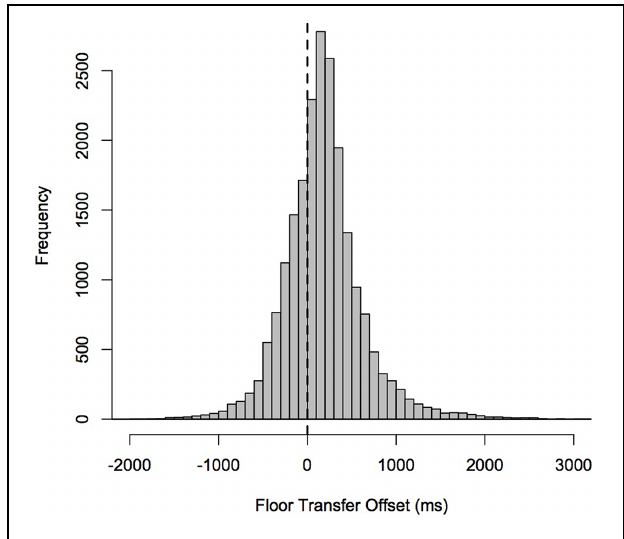
FIGURE 2 | Histogram of floor transfer offsets (FTOs) in the Switchboard Corpus (Godfrey et al., 1992; Calhoun et al., 2010, see Section 5.2.1 for details). Each bin has a size of 100 ms.